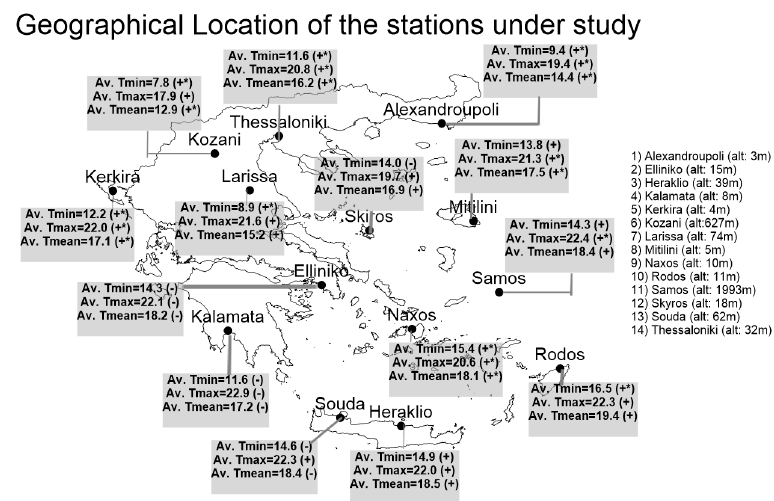
Figure 1. Geographical distribution of the stations under study. For each station, the altitude where it is located can be found on the right of the map. For each station, the average Tmin, Tmax, and Tmean values for the period 1958–2012 are provided. The sign of the trend of these time series is found in the brackets (). The asterisk indicates the statistical significance of the trends at the 95% level of significance.